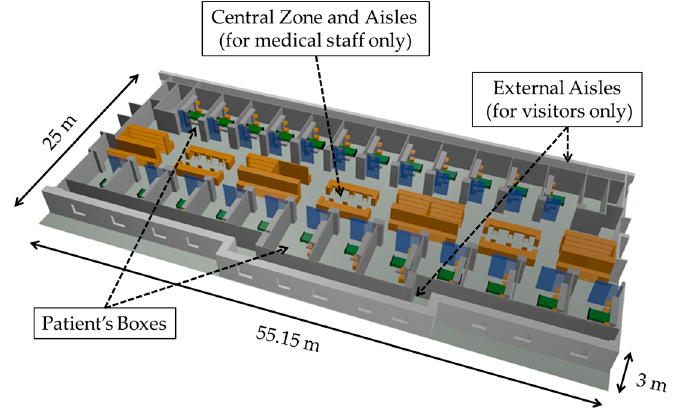
Figure 3. UCI-A scenario created for its simulation with the in-house 3D Ray Launching algorithm.